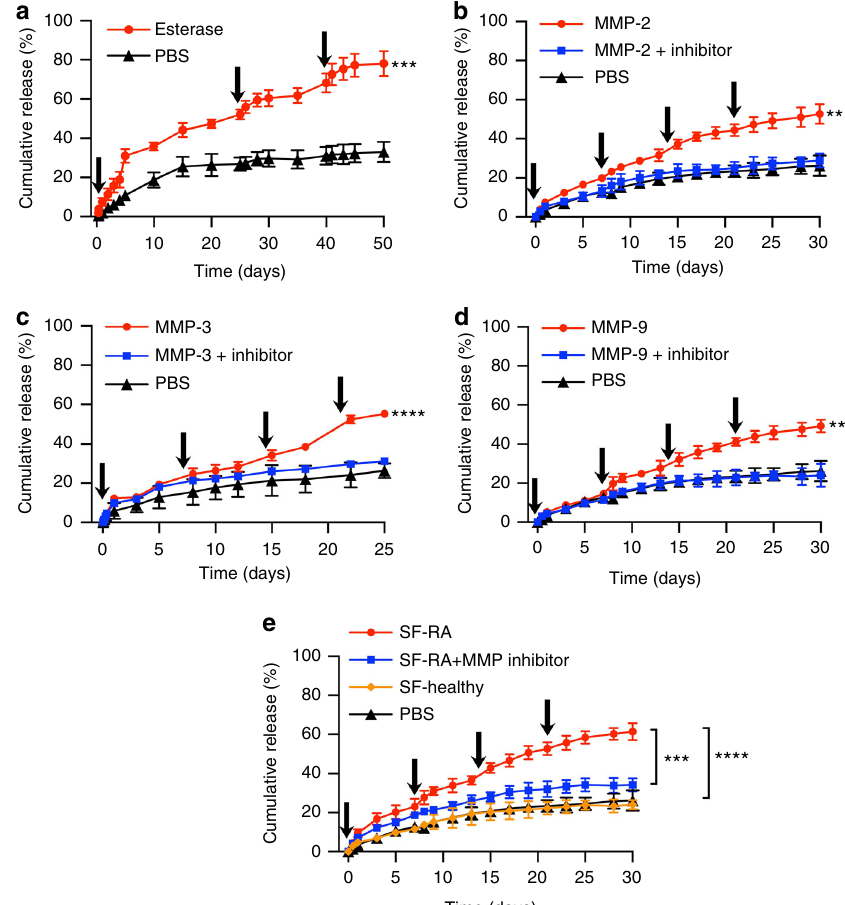
Fig. 2 TG-18 hydrogel has long-term hydrolytic and encapsulation stability in PBS and exhibits on-demand release of encapsulated TA. a In vitro release kinetics of TA from TG-18 hydrogel in PBS at 37 °C without or with esterase ( T. lanuginosus lipase, 200 U/ml). Fresh enzyme was added at the indicated time points (arrows). *** P < 0.001 compared with PBS on day 50. b – d In vitro release kinetics of TA from TG-18 hydrogel in PBS at 37 °C without or with MMP-2 (1.5 µ g/ml), MMP-3 (5 µ g/ml), or MMP-9 (1 µ g/ml). Fresh enzyme or enzyme + MMP inhibitor was added at the indicated time points (arrows). ** P < 0.01 compared with PBS or MMP-2 (MMP-9) + inhibitor on day 30 and **** P < 0.0001 compared with PBS or MMP-3 + inhibitor on day 25. e In vitro release kinetics of TA in response to synovial fl uid from human rheumatoid arthritis joints (SF-RA) and synovial fl uid from healthy human joints (SF- healthy). Two hundred microliters of fresh synovial fl uid or synovial fl uid + MMP inhibitor cocktail were added at the indicated time points (arrows). **** P < 0.0001 and *** P < 0.001 on day 30. P -values were determined by Student ’ s t -test with Welch ’ s correction in a and one-way Anova with Tukey ’ s post